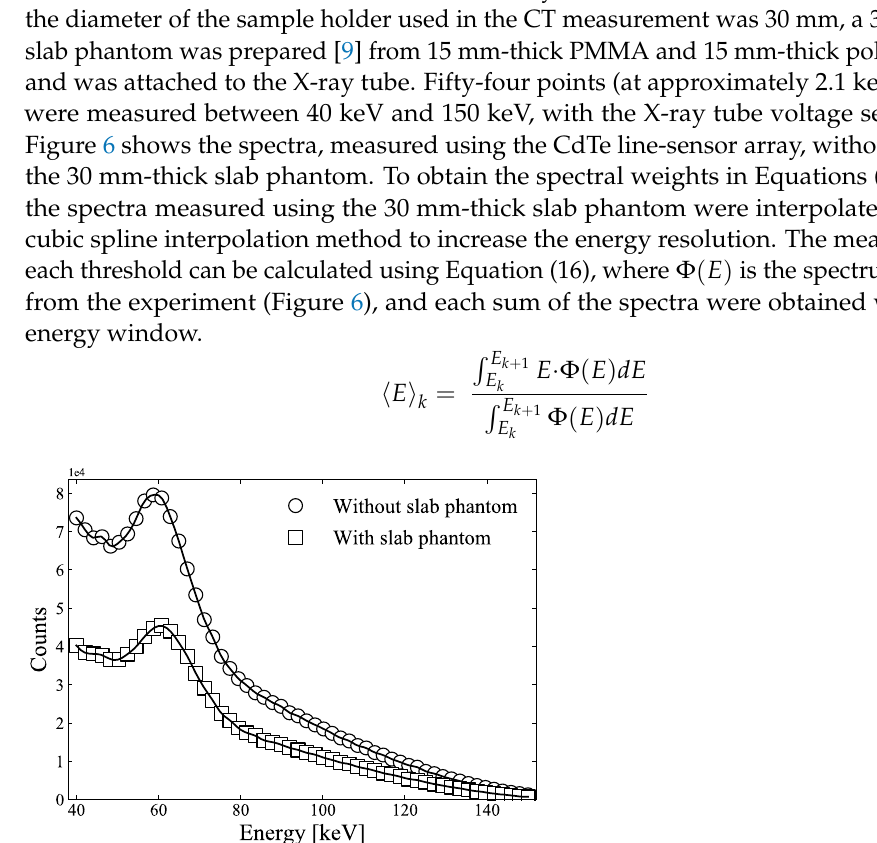
Figure 6. Spectra measured using CdTe line-sensor array, without and with 30 mm-thick slab phantom. Solid lines were calculated using the cubic spline interpolation